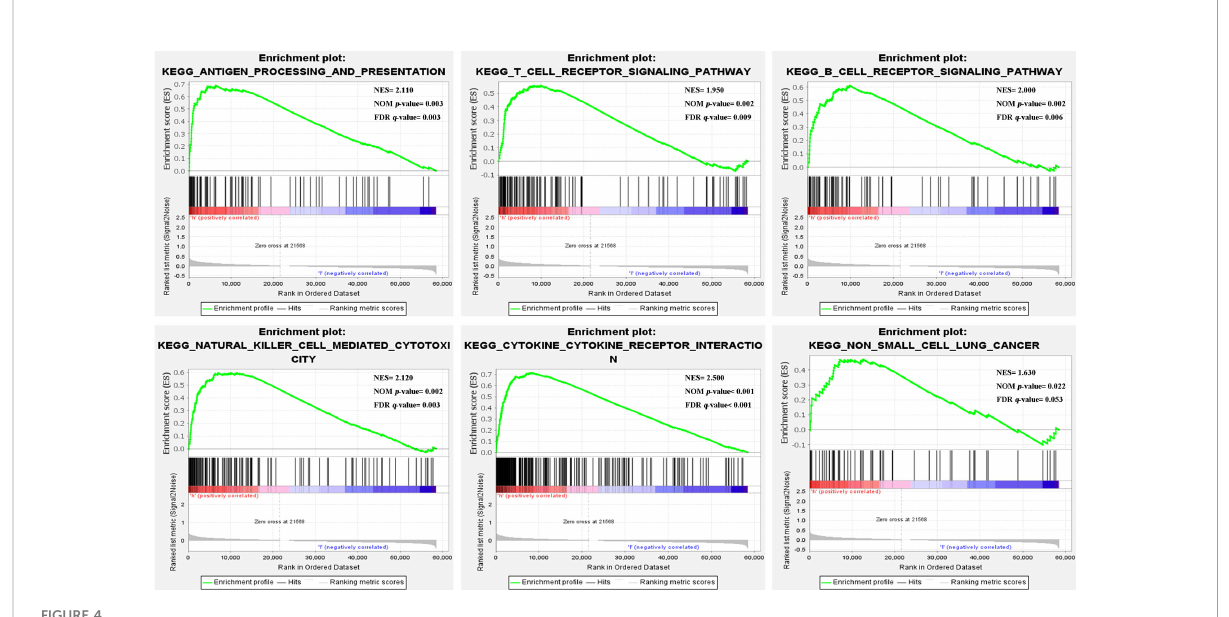
FIGURE 4 Gene set enrichment